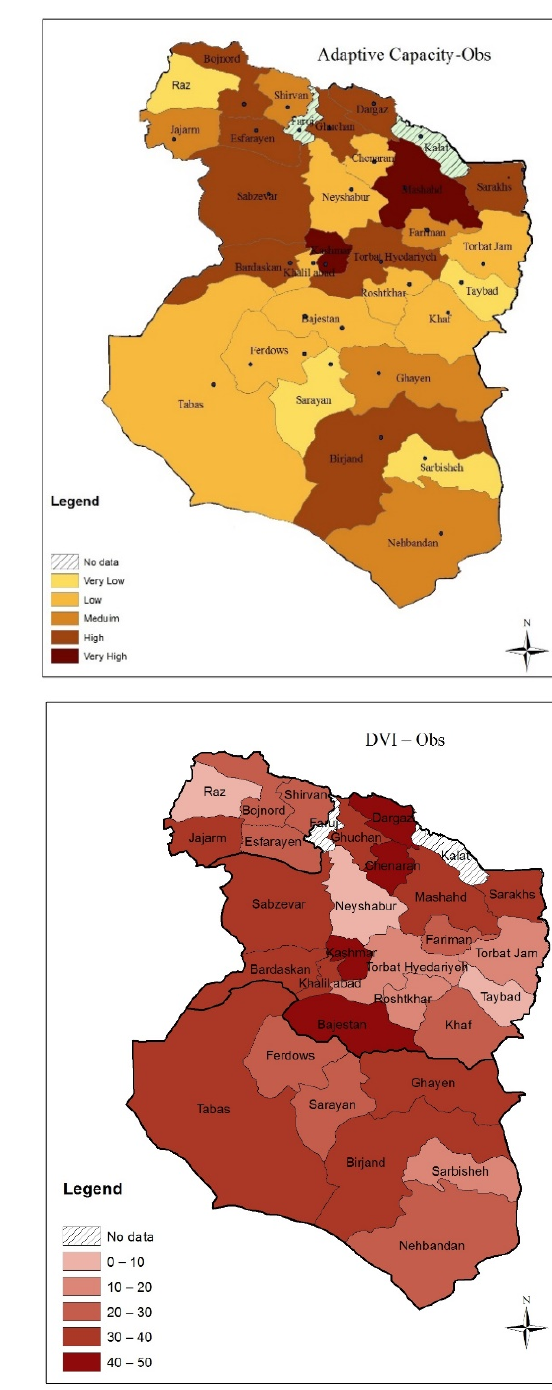
Figure 5. Maps showing an overview of Exposure/SPEI ( upper-left panel ), Adaptation Capacity ( upper-right panel ), and Sensitivity ( lower-left panel ) and resulting DVI ( lower-right panel ) during 1986–2005.